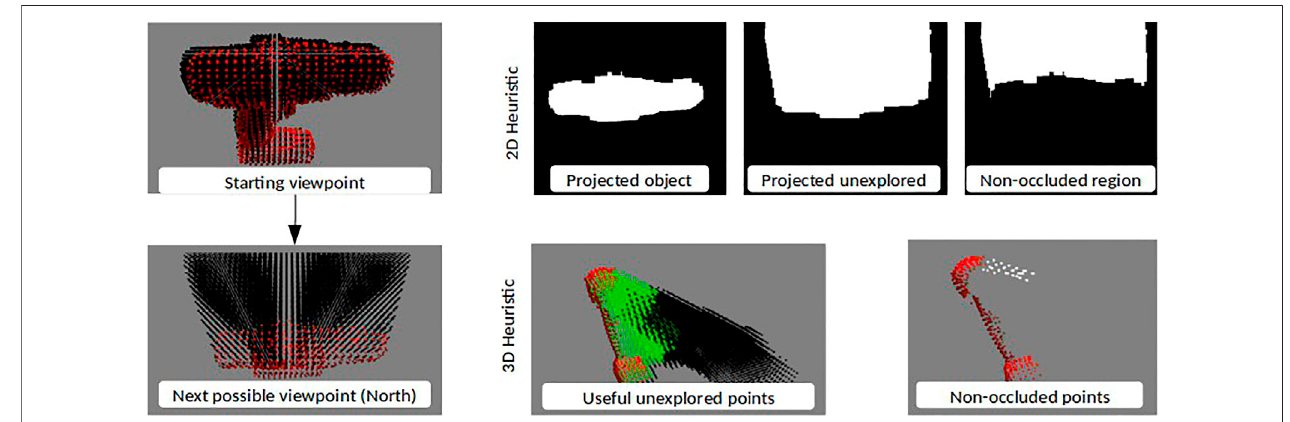
FIGURE 4 | Set of images illustrating how the 2D and 3D Heuristics evaluate a proposed next step North with the drill object. The 3D Heuristic images have been shown from a different viewpoint for representation purposes.